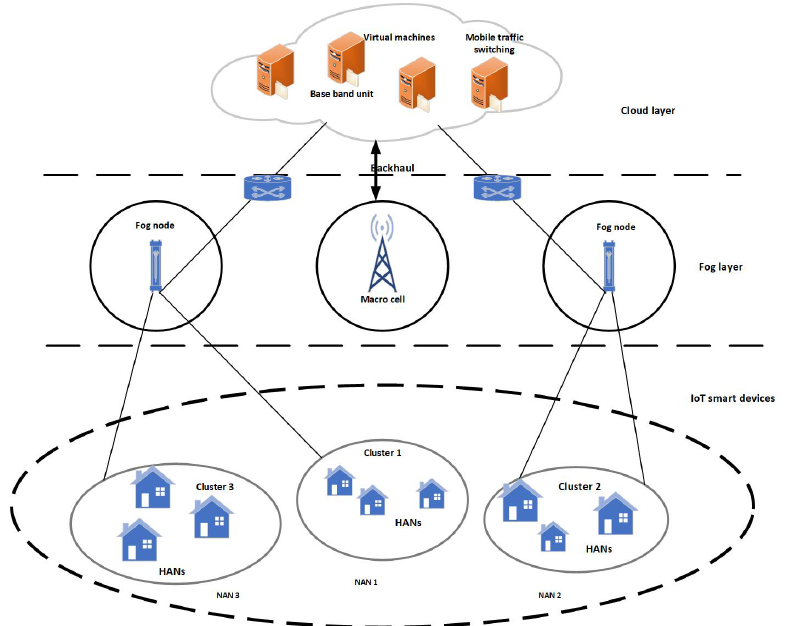
Figure 5. Smart IoT fog based architecture